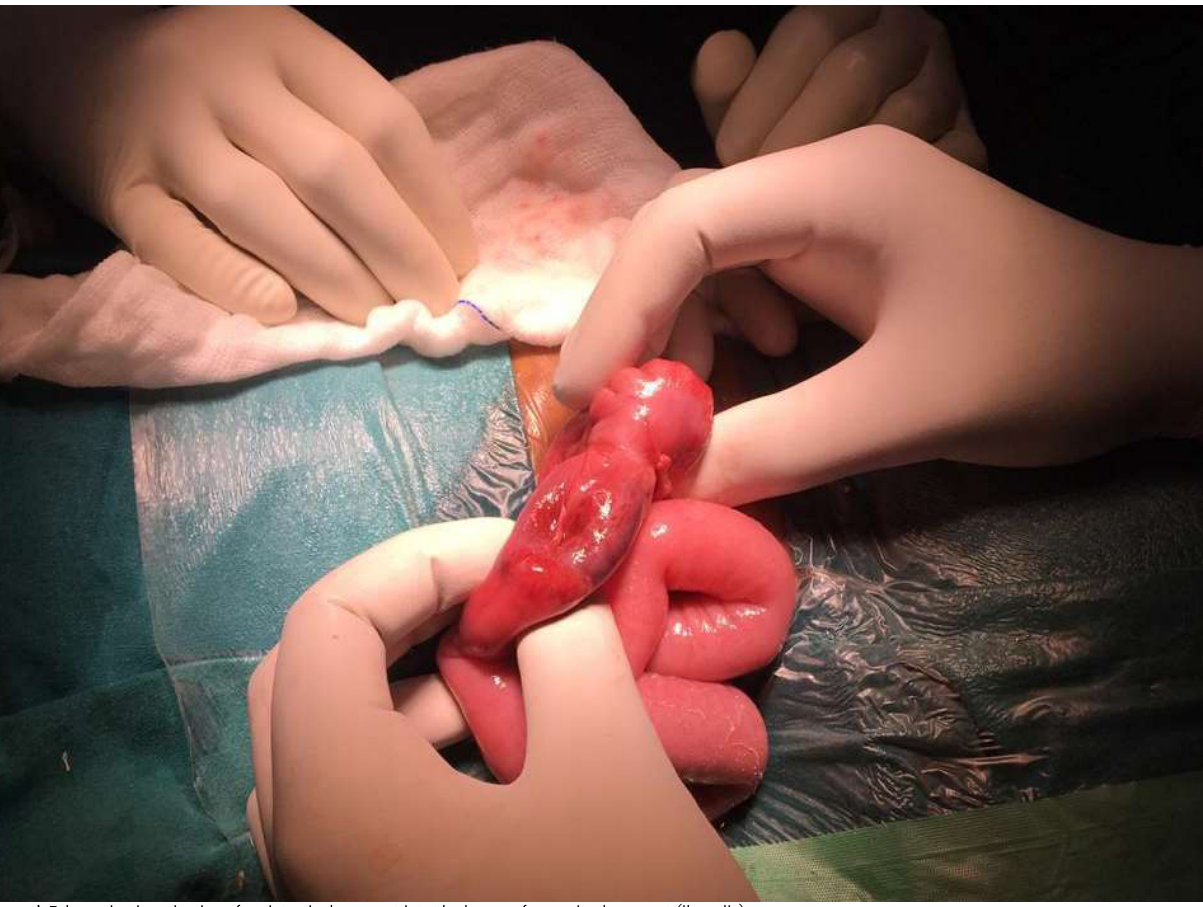
Legend: Telescoping invagination of an intestinal segment into the lumen of a proximal segment